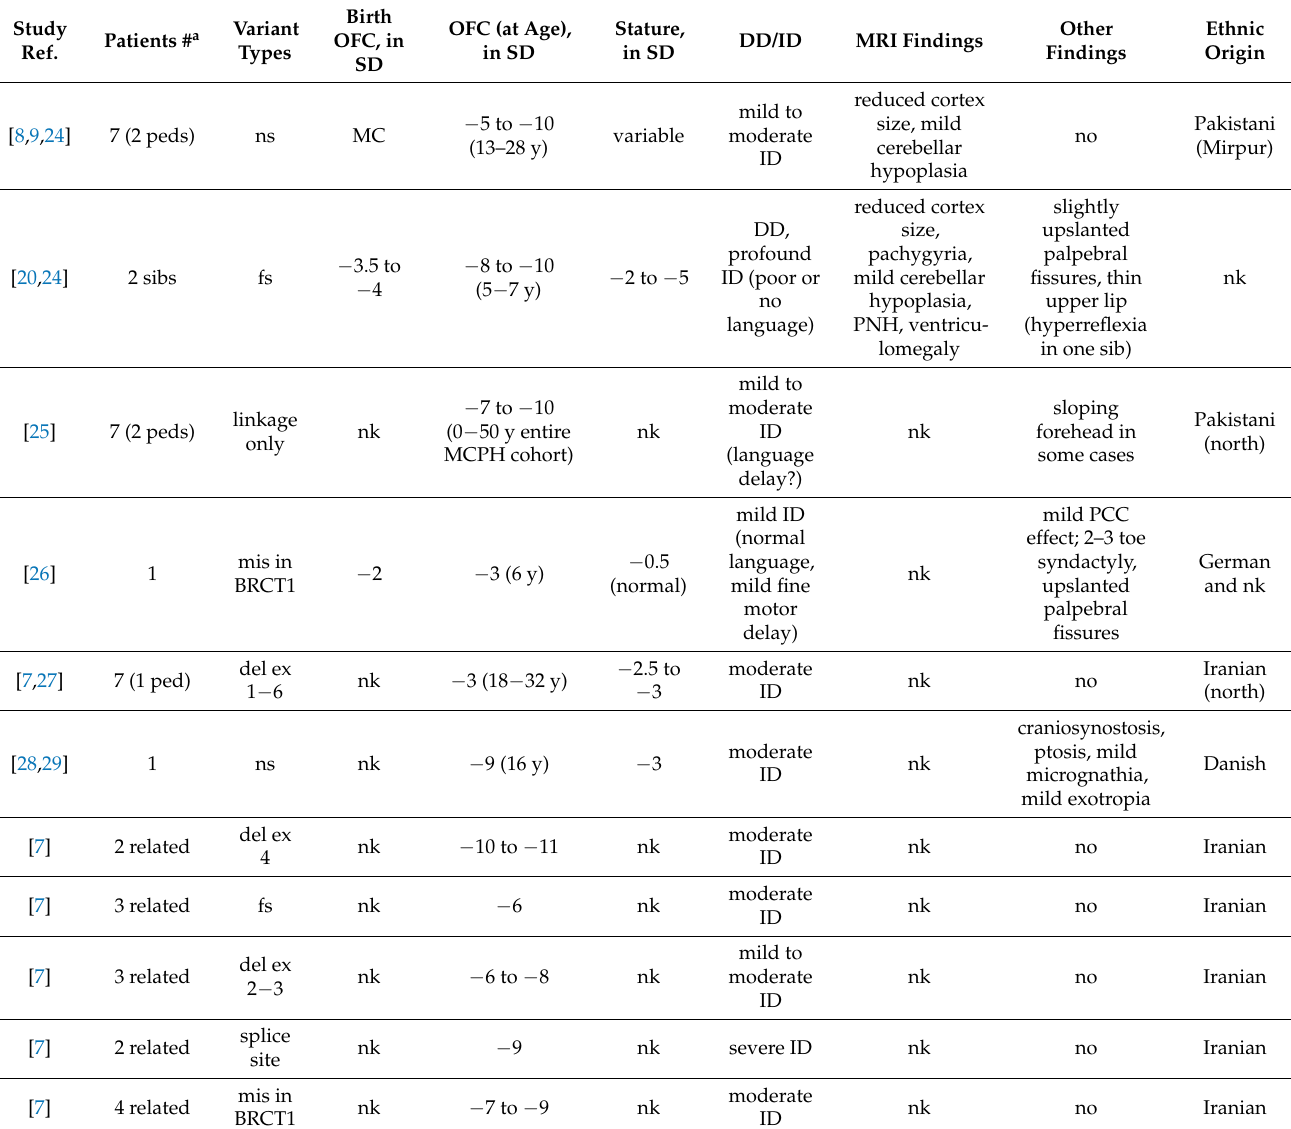
Table 1. Summary of the clinical findings in families with MCPH1 -related primary microcephaly described in the